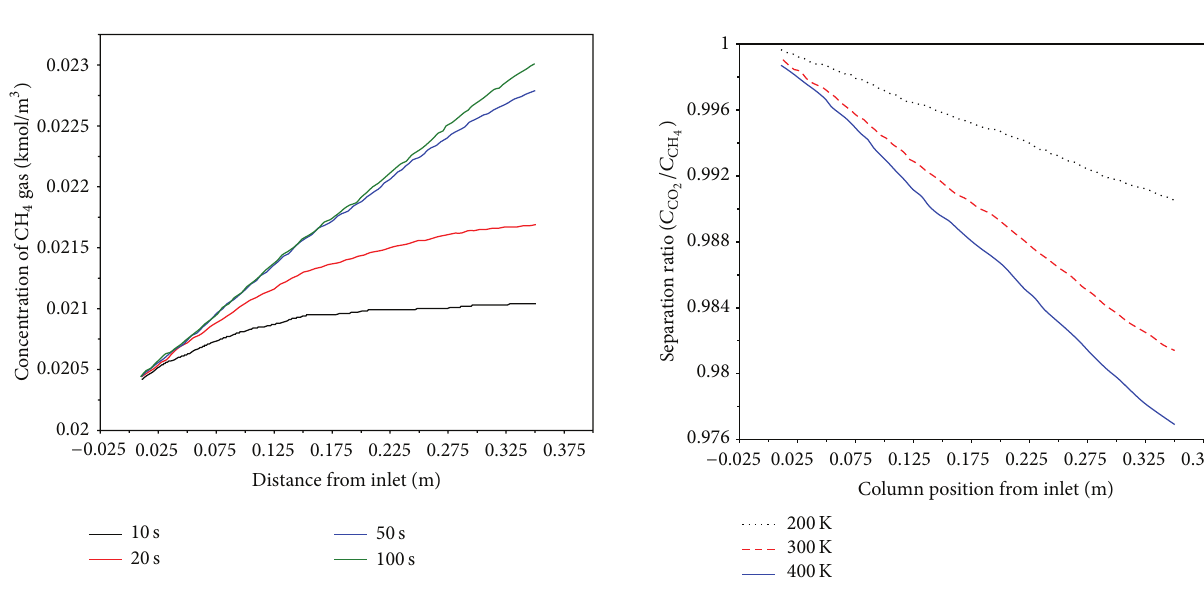
Figure 5: Temperature effects on separation ratio (flow velocity = 0.15 m/sec and pressure = 15